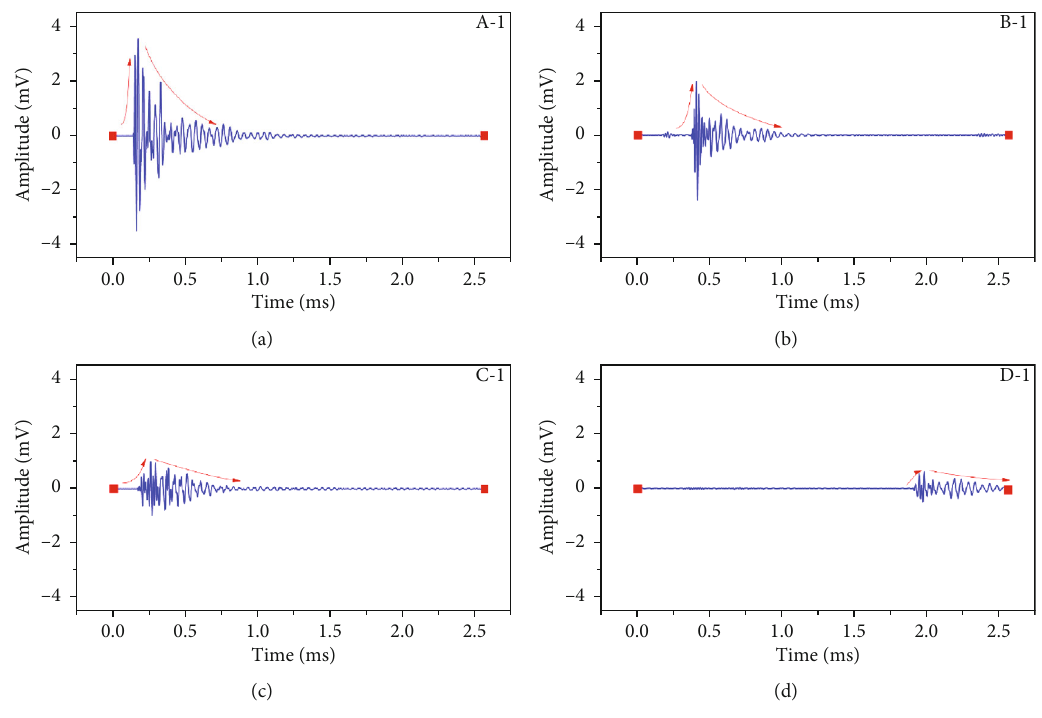
Figure 7: The original waveform when the samples